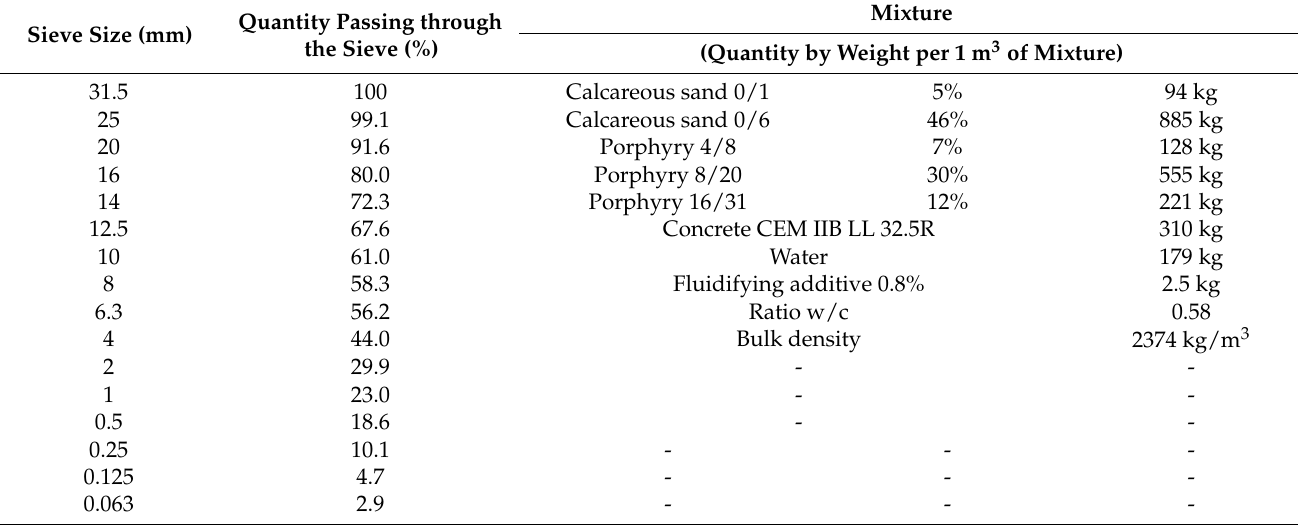
Table 5. Aggregate mixture with porphyry. On the left side, the quantity passing through the sieve expressed in percentage of the porphyry and the sieve size used; on the right side, the component used for the mixture. Sieve Size